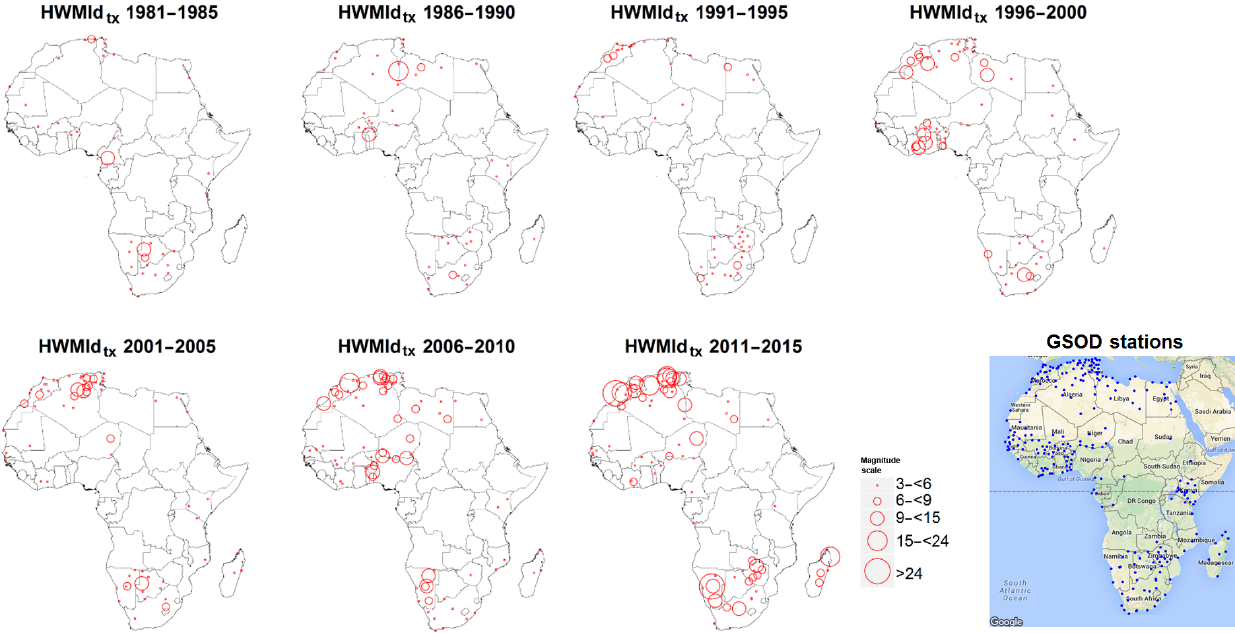
Figure 1. Heat Wave Magnitude Index daily of maximum temperature (HWMId tx ) for 5-year periods of GSOD records from 1981 to 2015. The bottom-right panes show the spatial distribution of the GSOD station employed in this